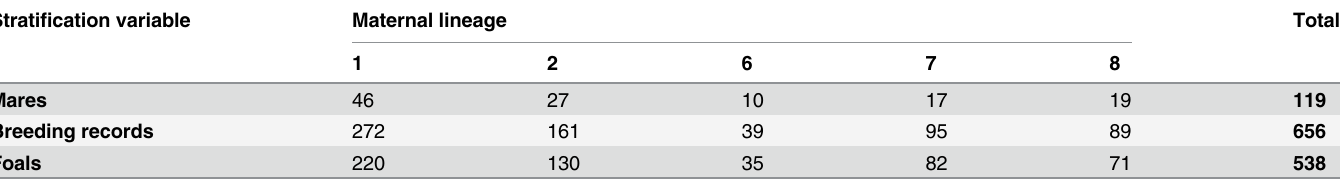
Table 1. Distribution of data among the maternal lineages. Numbers of Warmblood mares, breeding records (breeding seasons x mares) and pregnan- cies that resulted in birth of a living foal and their affiliation to the five individual mare families with more than 10